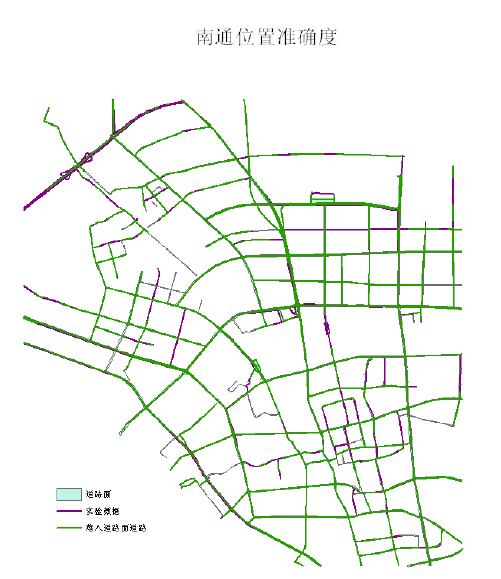
Figure 14 Nantong Position